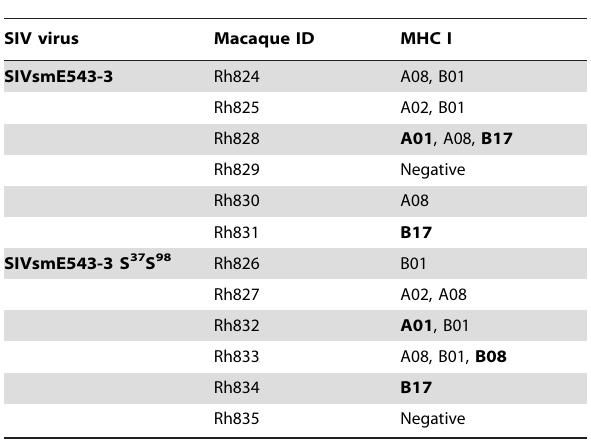
Table 2. MHC genotype of